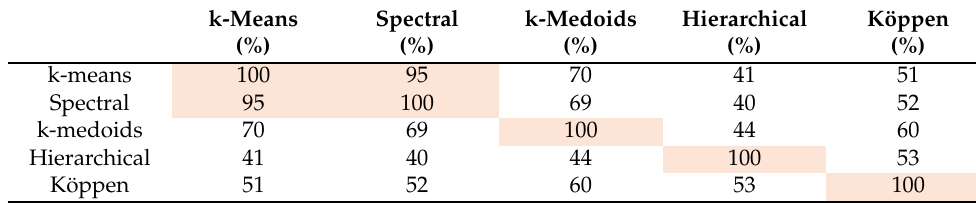
Table 5. Rand Index (RI) for 3 clusters.